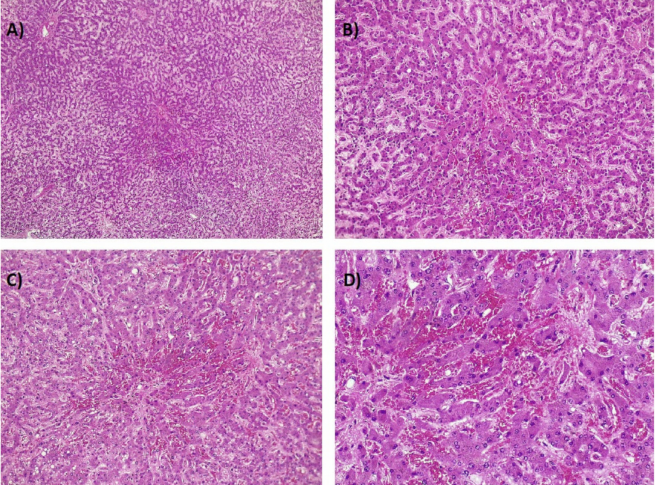
Figure 6. ( A – D ). Postmortem example of a patient with sinusoidal obstruction syndrome. As in Figure 5, centrilobular regions show congestion and extravasation of red blood cells (increasing magnification from ( A ) to ( D ): 4 × , 10 × , 20 × , and 40 × ; hematoxylin-eosin